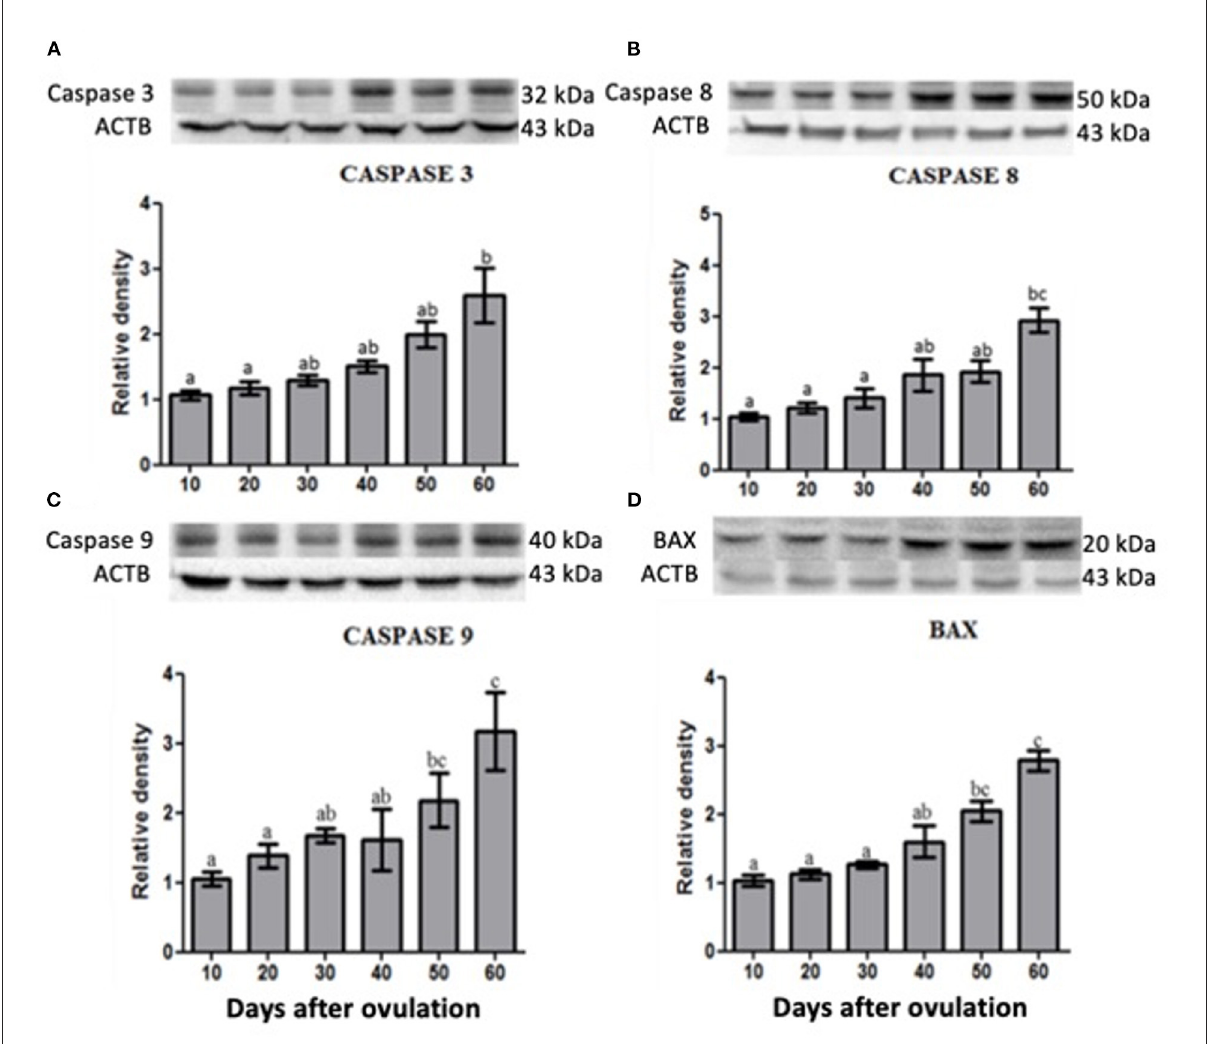
FIGURE5 Protein expression of Caspase 3 (A) , Caspase 8 (B) , Caspase 9 (C) and BAX (D) in canine corpus luteum. Representative blots on top of each column, which represent mean ± standard error ( n = 4/group). Different letters indicate significant differences among groups ( P ≤